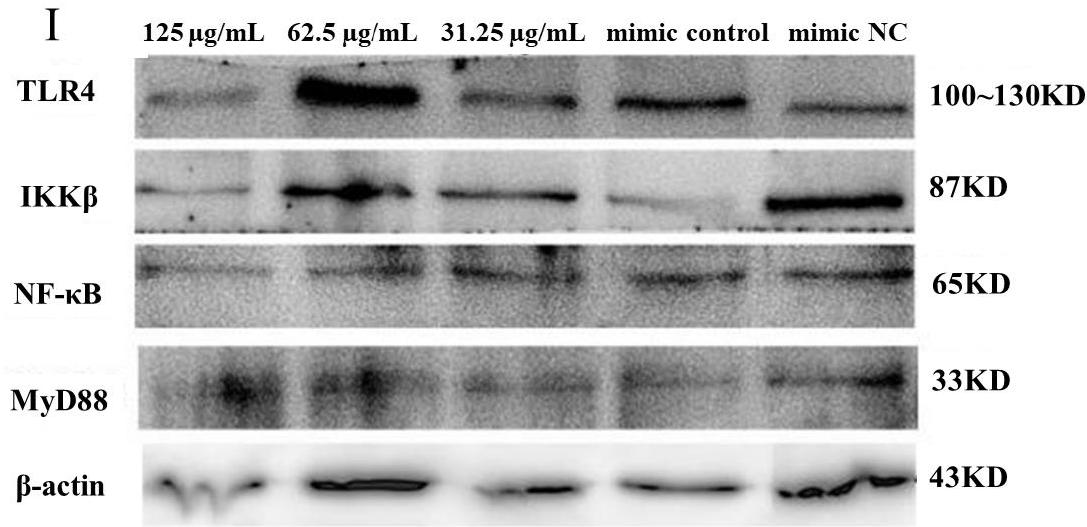
Figure 10. Influence of OPL on mRNA and protein expression after transfection with miR-4796 mimic. ( A ): TLR4 mRNA expression level; ( B ): MyD88 mRNA expression level; ( C ): IKK β mRNA expression; ( D ): NF- κ B mRNA expression; ( E ): TLR4 protein expression level; ( F ): MyD88 protein expression level; ( G ): IKK β protein expression level; ( H ): NF- κ B protein expression level; ( I ): protein bands. Each value represents the mean ± SD ( n = 3). * p < 0.05, ** p < 0.01 compared with the control group.